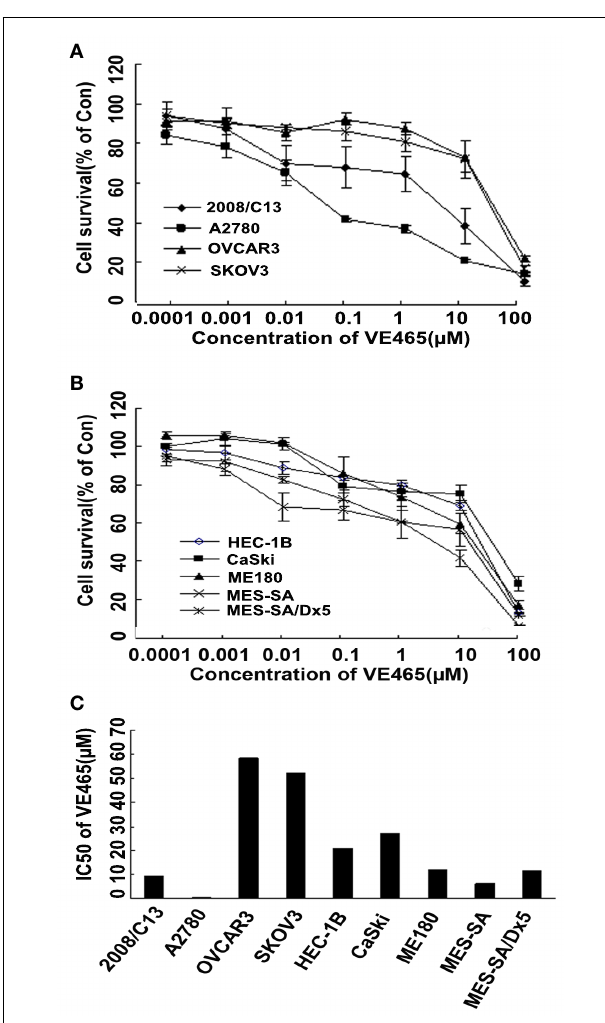
FIGURE 2 | Cytotoxicity in gynecologic cancer cell lines after 72h of treatment withVE465 alone. (A) Growth curves for ovarian cancer cell lines (2008/C13, A2780, OVCAR3, and SKOV3) after treatment withVE465 alone at increasing concentrations (0.0001–100 µ M). (B) Growth curves for uterine and cervical cancer cell lines (ME180, CaSki, HEC-1B, MES-SA, and MES-SA/D × 5) after treatment withVE465 alone at increasing concentrations (0.0001–100 µ M). (C) IC 50 ofVE465 in various gynecologic cancer cell lines.